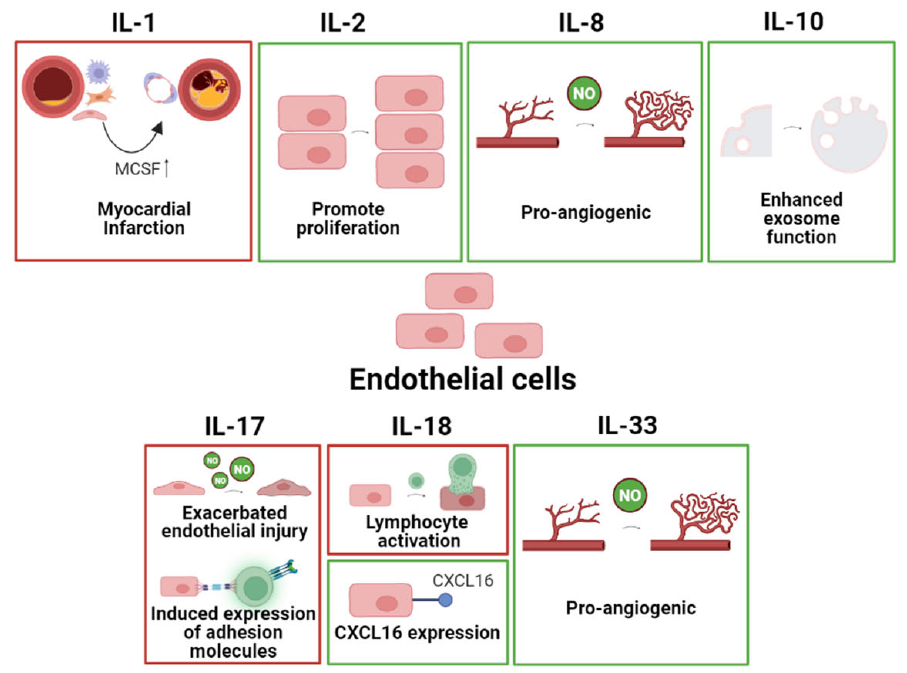
Figure 3. The specific pathophysiological effects of different interleukins on ECs in common heart disease. The box in red represents the deleterious role, and the box in green represents the protective role.